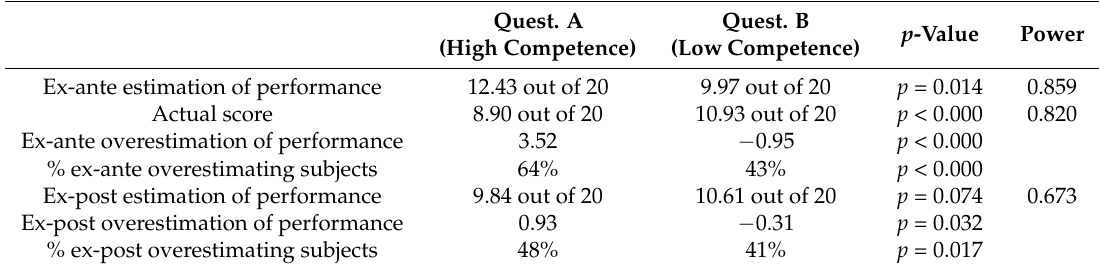
Table 5. The estimation and perceived competence in the No Self Selection treatment